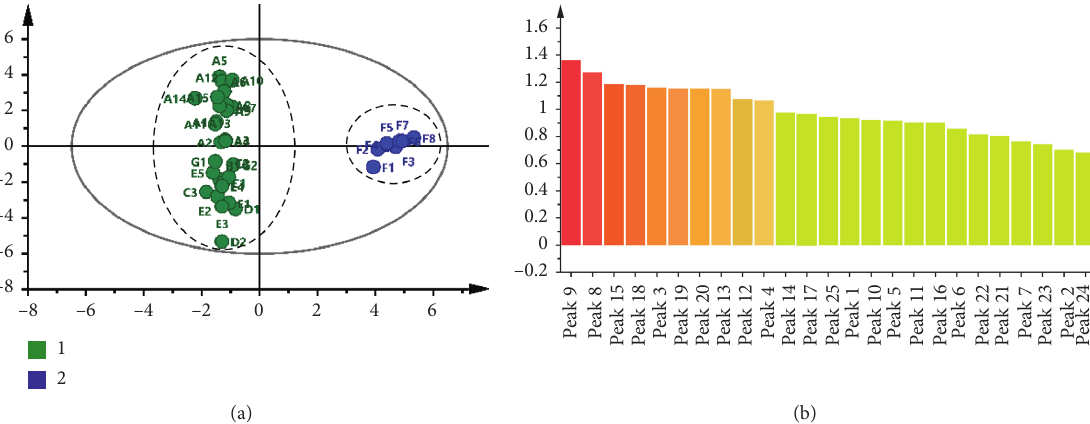
Figure 6: (a) The OPLS-DA results of different batches of XJC samples; (b) the VIP values of 25 common peaks in the OPLS-DA values of twenty-five common peaks were extracted and arranged from large to small in the OPLS-DA model (Figure 6(b)). The VIP values of the peaks 9, 8, 15, 18, 3, 19, 20, 13, 12, and 4 were greater than 1; it means that these common peaks played more important roles in distinguishing the two groups of XJC samples. Among them, peak 9 originated from SX, peak 8 originated from FXZ and XM, peak 15 originated from DG and FXZ, peak 18 originated from MY, DL, and RX, peak 3 originated from WLZ, SX, and MBZ, peak 19 originated from FXZ and RX, peak 20 and peak 13 originated from FXZ, peak 12 originated from MY, and peak 4 originated from WLZ. Overall, the above 10 peaks originated from nine herb materials making up XJC except CW. The